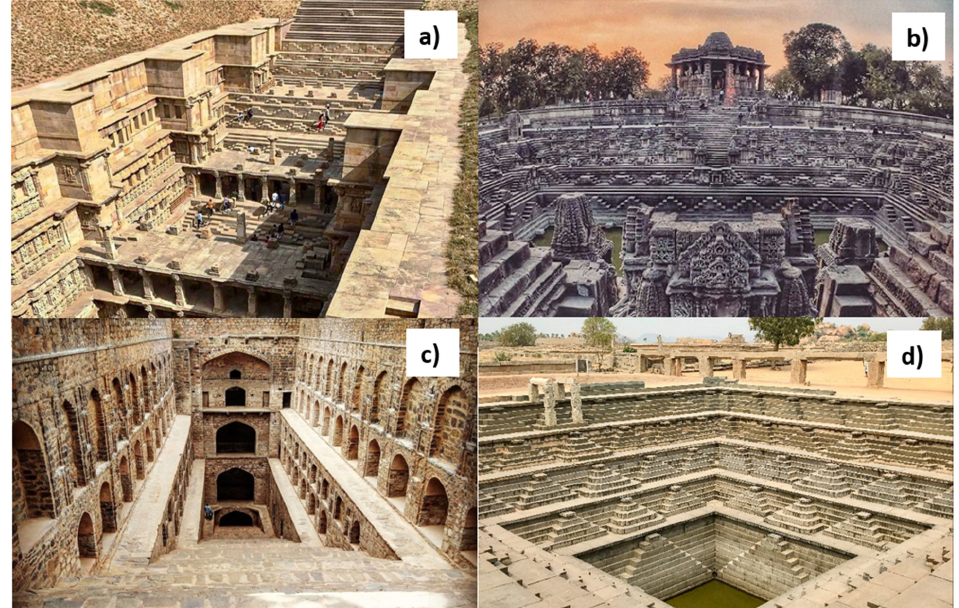
Figure 3. ( a ) Rani ki vav, Gujarat https://www.gujarattourism.com/north-zone/patan/rani-ki-vav.html, accessed on 20 July 2022; ( b ) Modhera stepwell, Sun temple, Gujarat;